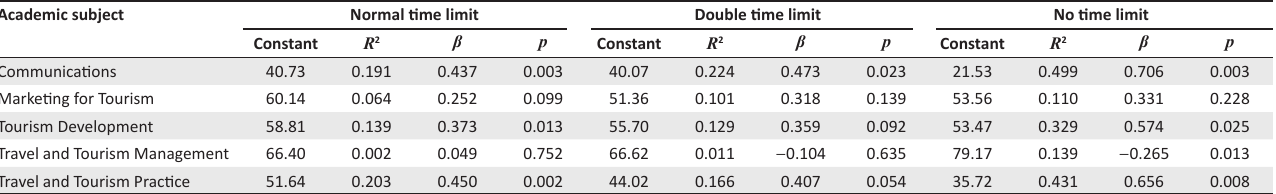
TABLE 3: Regression values for the Cloze procedure test on first-test subject marks by time-limit group. Academic